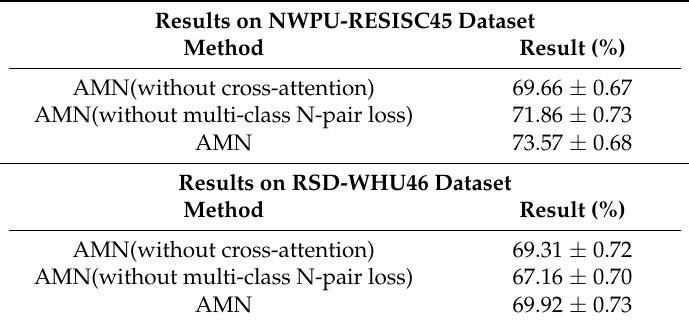
Table 6. Ablation studies on two different groups of